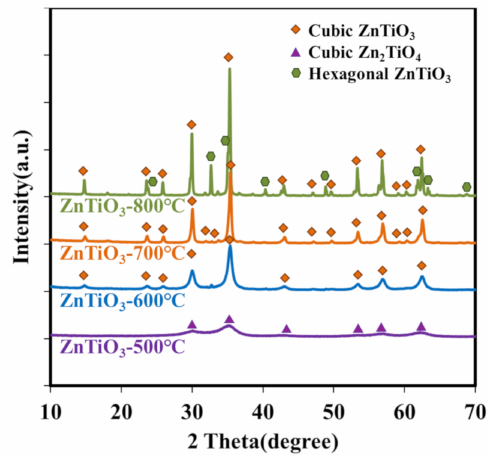
Figure 2. The XRD patterns of ZnTiO 3 photocatalysts (prepared by adding 1500 µ L NH 4 OH and 5 g PVP) at various calcination temperatures from 500~800 ◦